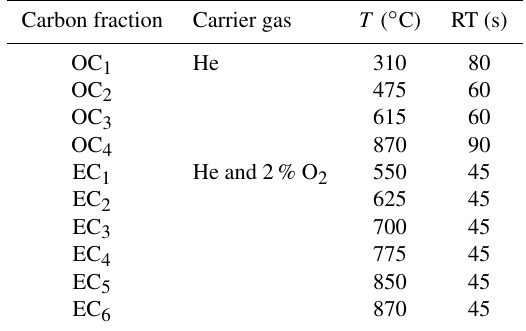
Table 1. Temperature ( T ) and residence time (RT) protocol of the semi-continuous Sunset OC / EC analyzer (Wu et al.,